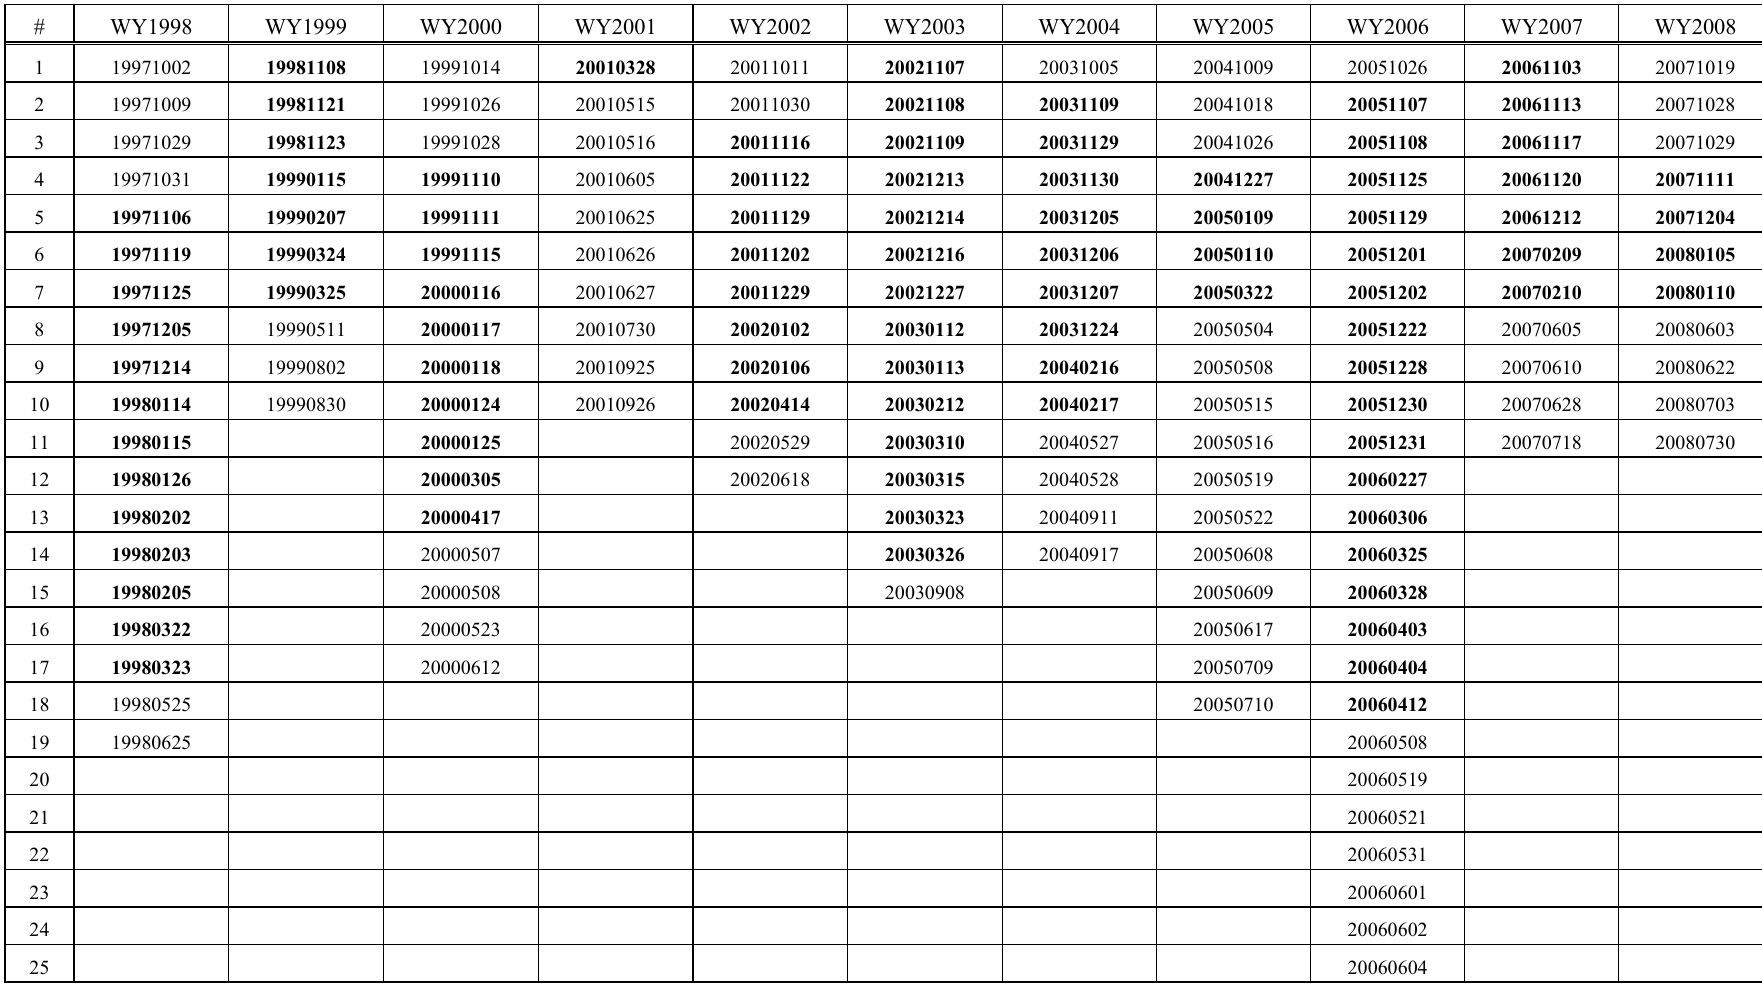
Table 1a. Dates of SSM/I observations of landfalling atmospheric rivers (ARs; long, narrow plumes of integrated water vapor with core values >~2 cm) during the water years 1998–2008 that impacted the California coast (32.5° N–41.0° N) on both the morning ascending SSM/I passes and the afternoon descending passes. The AR events in the November-April window considered in this paper are